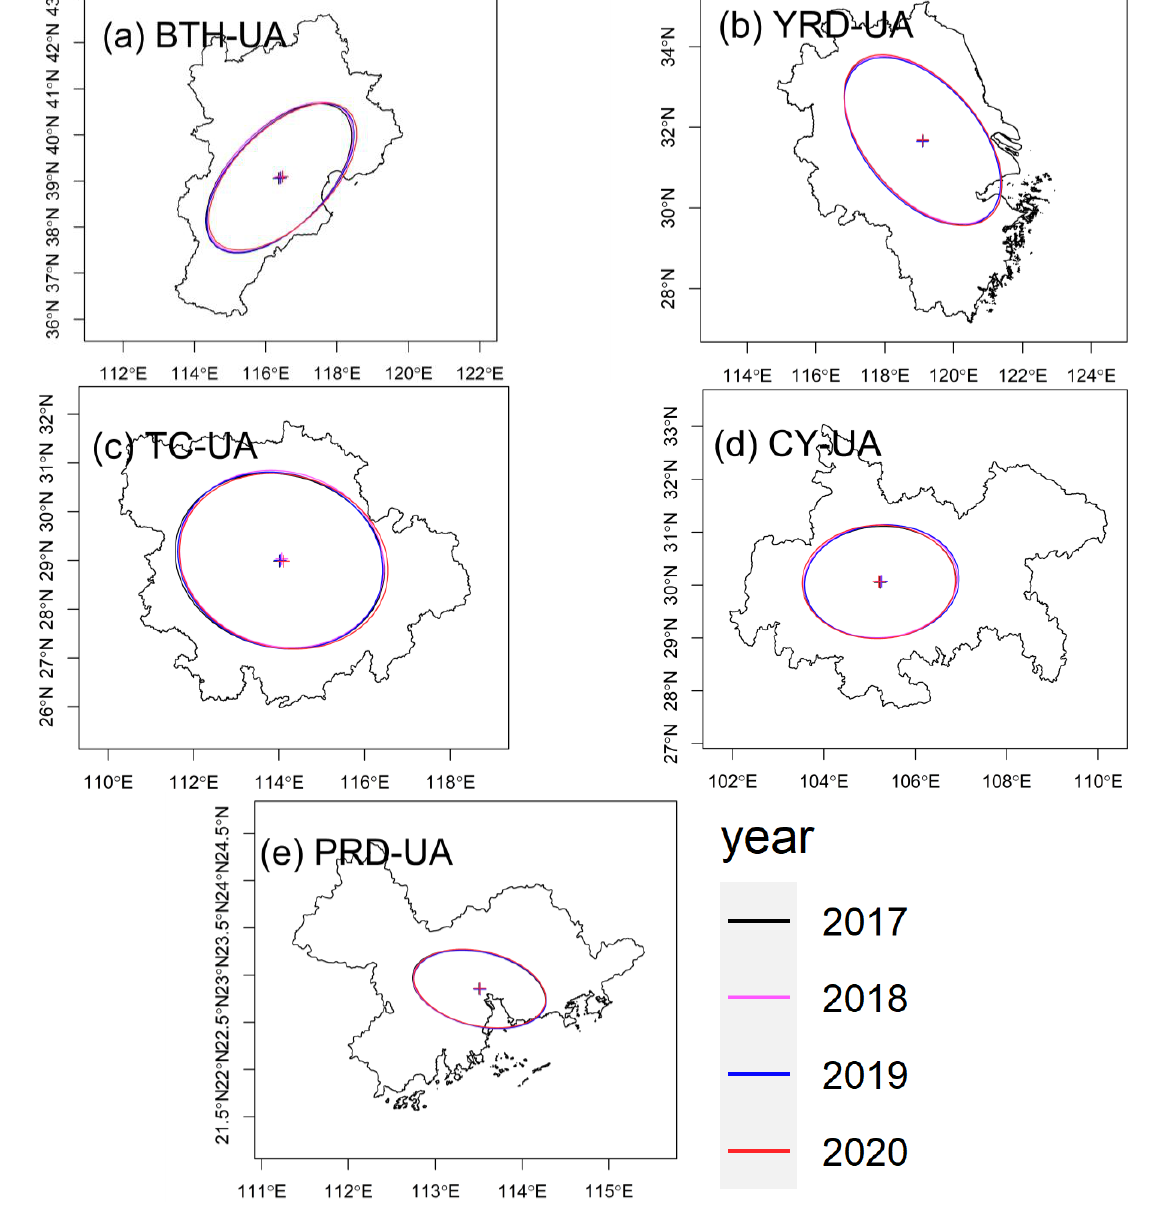
Figure 6. Standard ellipse deviation in ( a ) BTH-UA, ( b ) YRD-UA, ( c ) TC-UA, ( d ) CY-UA, and ( e ) PRD-UA during 2017 – 2020. ( e ) PRD-UA during